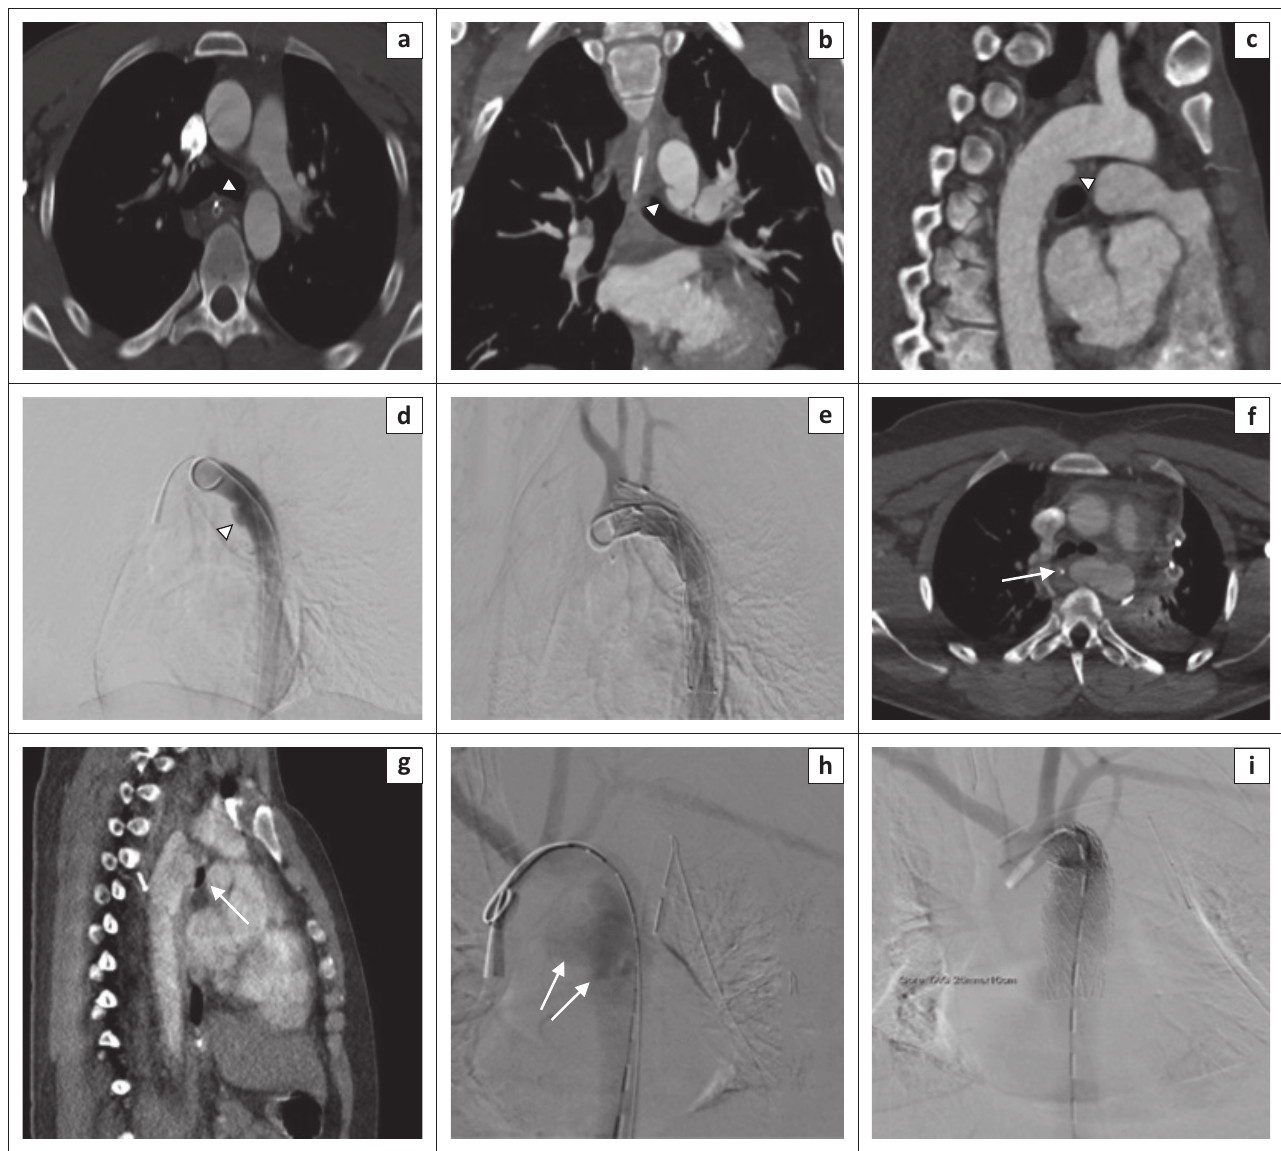
FIG URE 6: Aortic pseudoaneurysm (grade III) with respective endovascular intervention images in two different patients. Arrow head in (a) shows axial image of a subtle aortic small pseudoaneurysm, which is better demonstrated on MPR formats in (b) and (c). Arrow in another patient (f), (g) shows a larger pseudoaneurysm in the proximal descending aorta and mediastinal haematoma (indirect sign). Subsequent pre-intervention digital subtracted angiograms in (d) and (h) and respective post TEVAR images (e) and (i) demonstrating successful treatment of the